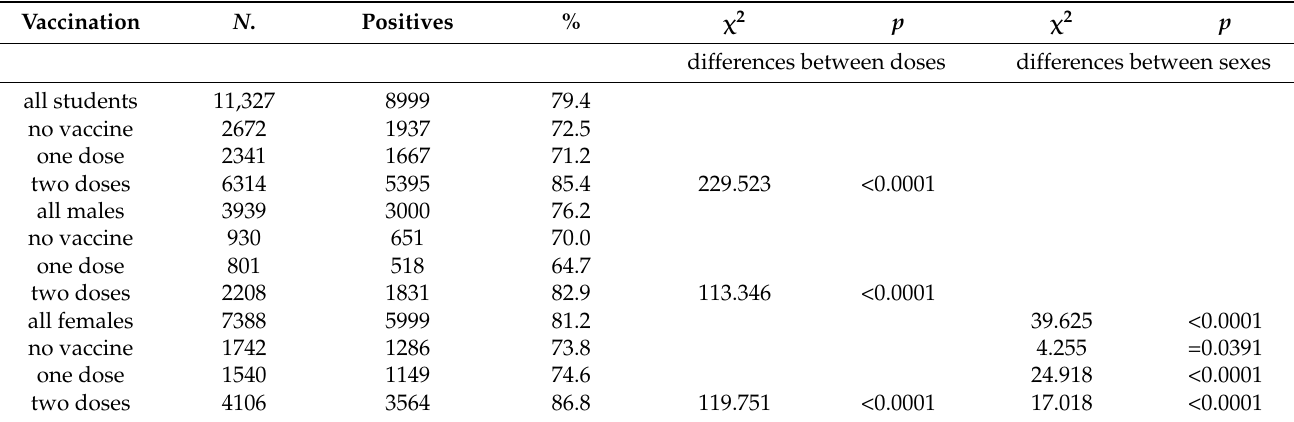
Table 2. Positivity of mumps antibodies according to vaccine doses and sex. Statistical analysis between doses, males and females are performed by the Chi-square ( χ 2 ) test with Yates’ correction.